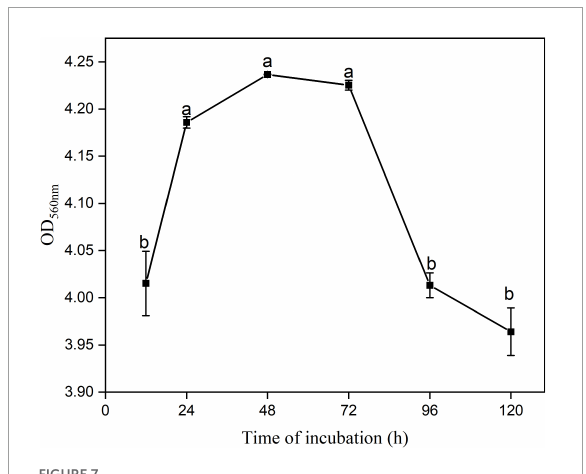
FIGURE7 The ability of B. tequilensis YYC 155 to form a biofilm at 28 ◦ C. Three duplicate wells are used for YYC 155 at each time point. Data represent the mean ± standard error (se). Different letters represent significant differences in biofilm-forming capacity at the designated timepoint as determined by Duncan’s multiple range test ( P <